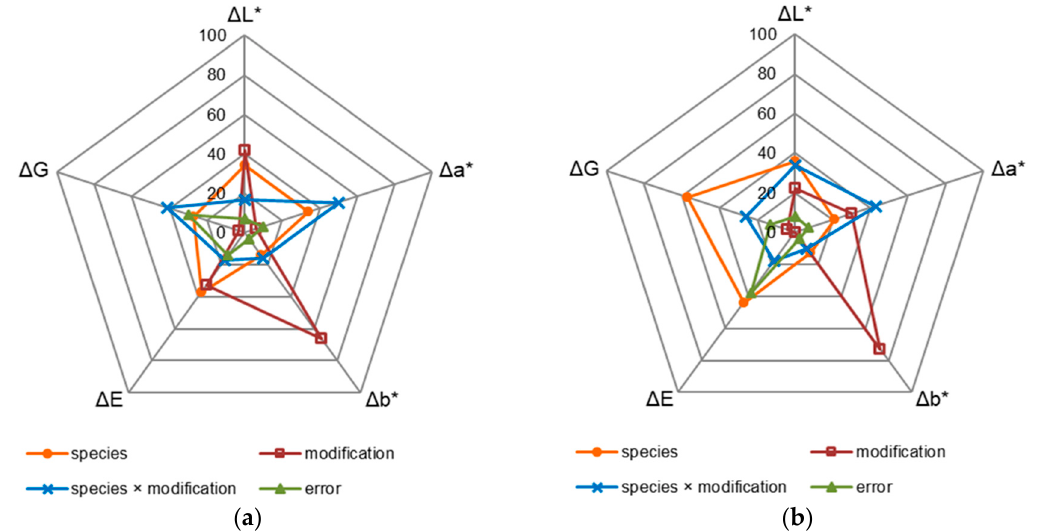
Figure 7. The percentual influence of species and thermal modification on the changes of colour parameters ( Δ L*, Δ a*, Δ b*), Δ E, Δ G of wood after ( a ) varnishing and ( b ) oiling (numbers 0–100 in Figure—Influence of Factors (%)).